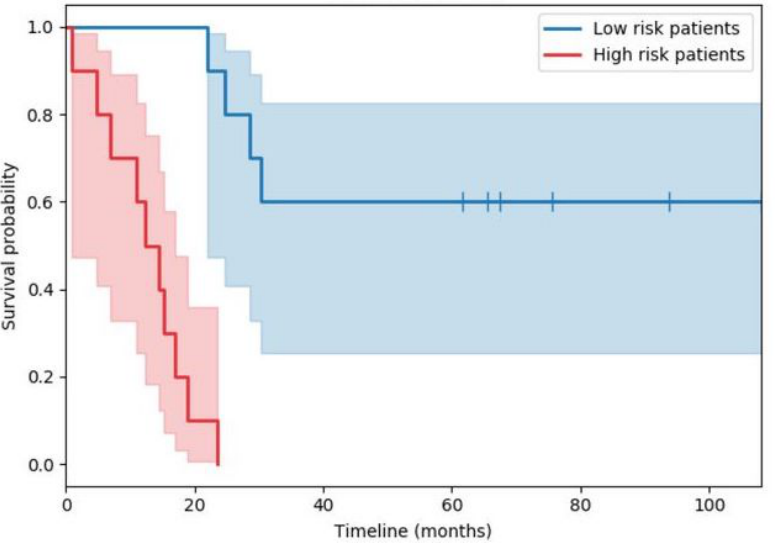
Figure 1. Example of the Kaplan–Meier derived estimate of two survival functions (red and blue lines). The corresponding shared areas indicate the standard deviations of the estimates across